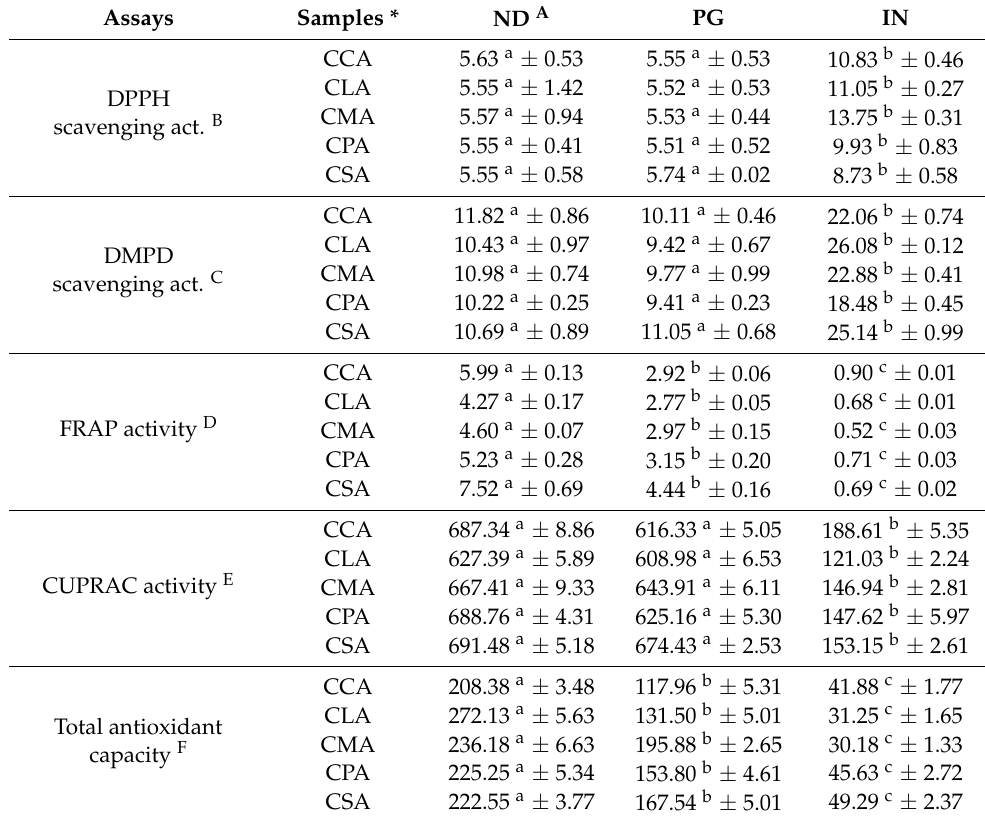
Table 3. Spectrophotometric determination of antioxidant activities of Cistus extracts.